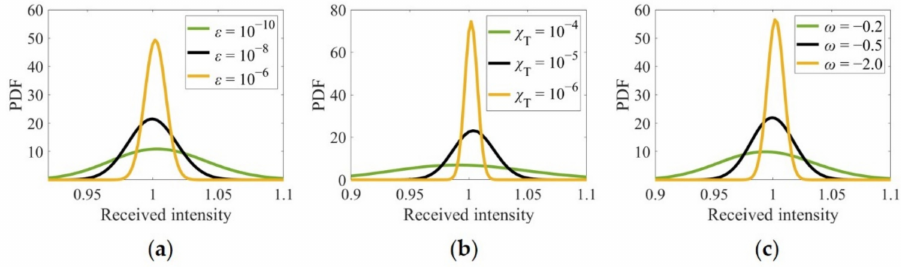
Figure 8. Simulated PDFs with different turbulence values of ( a ) ε , ( b ) χ T , and ( c ) ω .